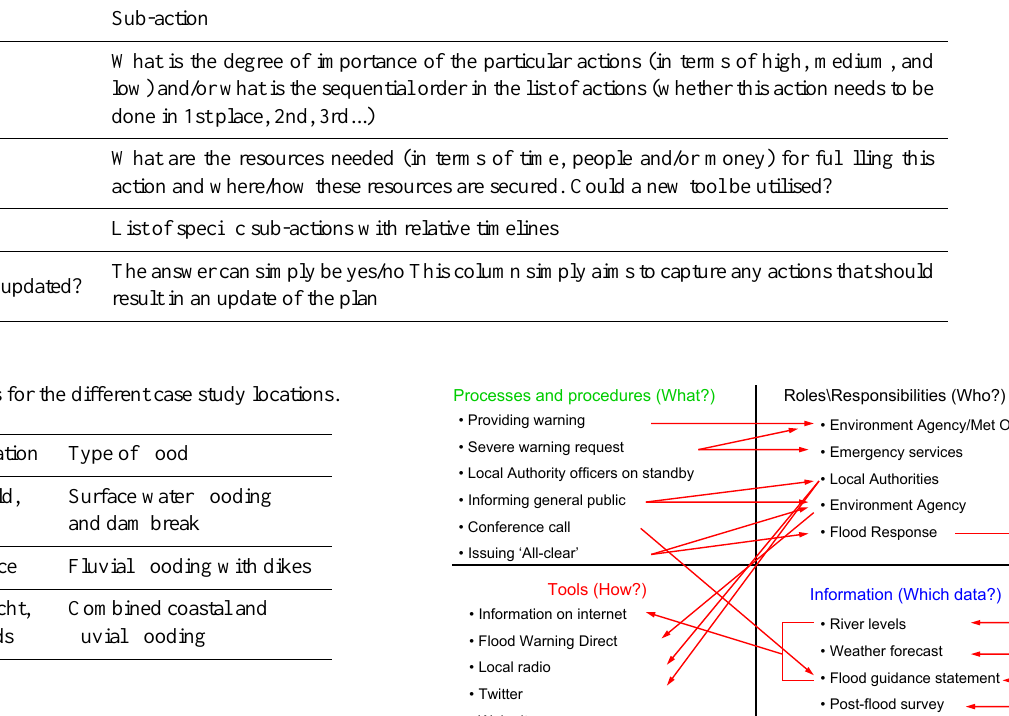
Table 2. Metrics used for the assessment of emergency plans for floods.